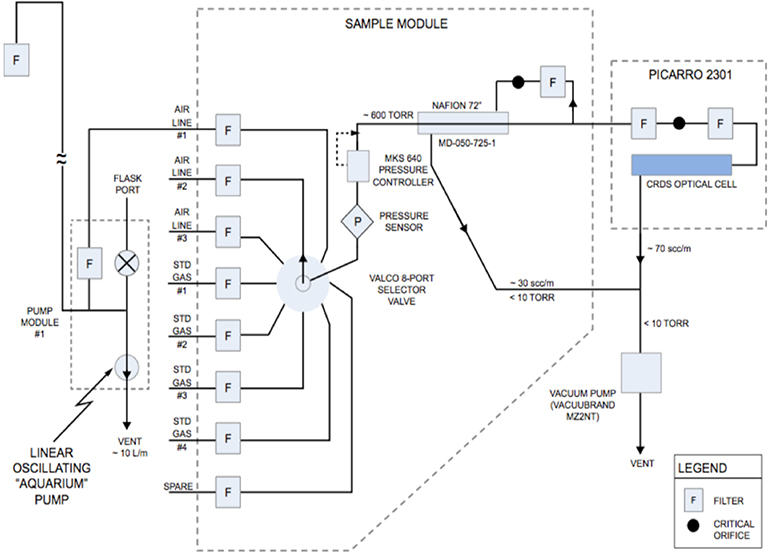
Plumbing diagram for the Earth Networks sampling system implemented at the NEC tower stations. Figure replicated from Fig. S1 in Verhulst et al. (2017), adapted from Welp et al. (2013).